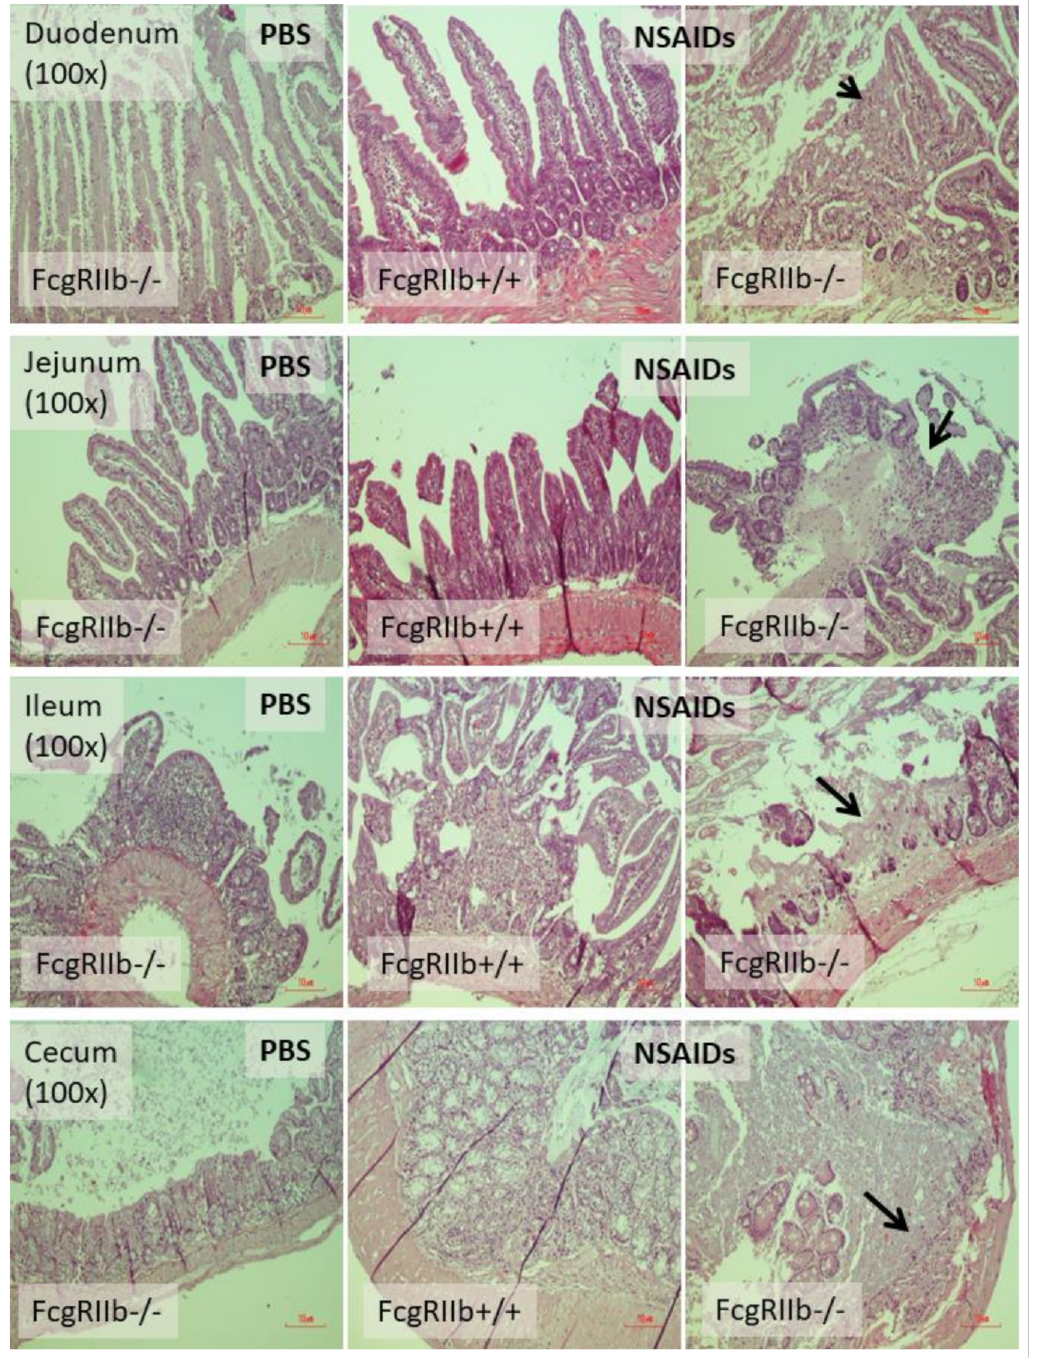
Figure 4. Representative figures of intestinal histology (hematoxylin and eosin staining) of FcgRIIb-/- lupus mice and wild-type (FcgRIIb+/+) mice after the administration of indomethacin (NSAIDs) or phosphate buffer solution (PBS) control (original magnification 200 × ) are demonstrated. of PBS-administered wild-type control mice (FcgRIIb+/+ PBS) were not demonstrated due to the similarity to FcgRIIb-/- PBS control mice. Arrow, raw surface of the intestinal mucosa indicates the intestinal